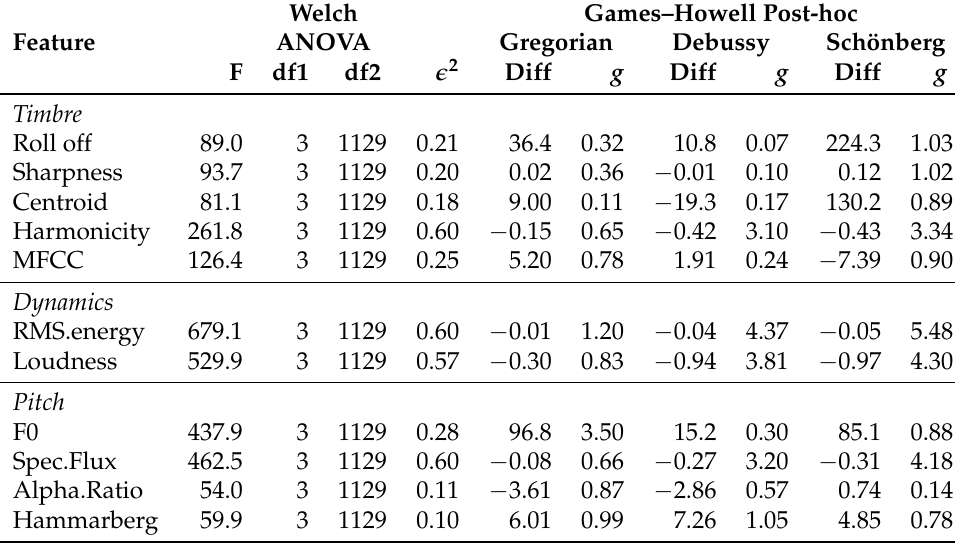
Table 3. Results for the Welch-ANOVA and Games–Howell (post-hoc test) on the NoAnx feature set considering Pachelbel’s canon as reference for the pairwise comparisons with the other samples: Gregorian chant, Debussy’s sample, and Schönberg’s sample. For the ANOVA, F score, degrees of freedom (df1 and df2), and epsilon squared ( (cid:101) 2 ) are indicated. For Games–Howell, the mean difference (Diff) and Hedge g are also given. Results are indicated for the three feature groups: timbre, dynamics, and